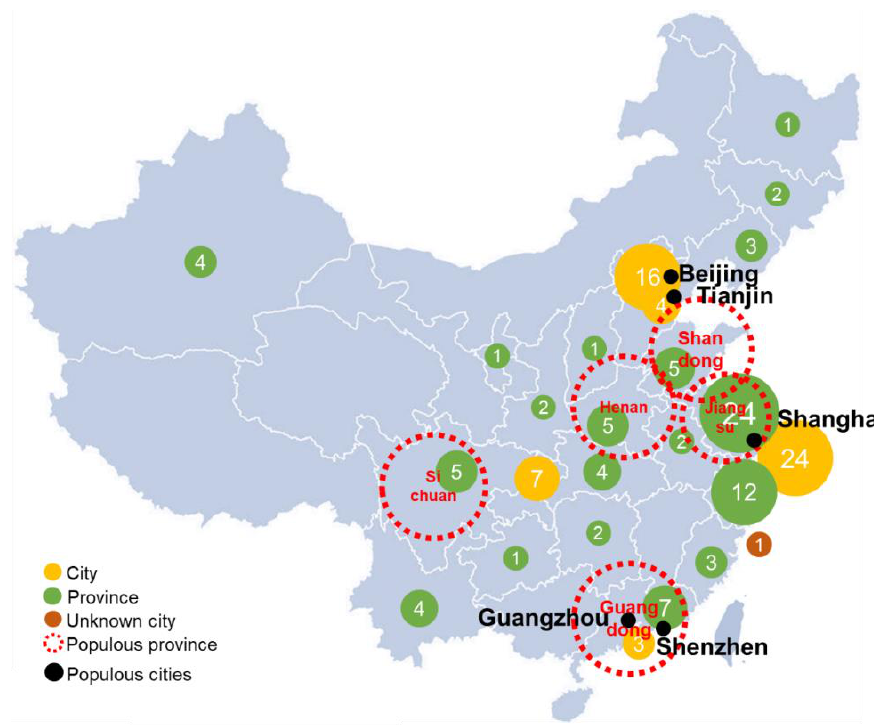
Figure 5. The distribution of urban water quality and population.